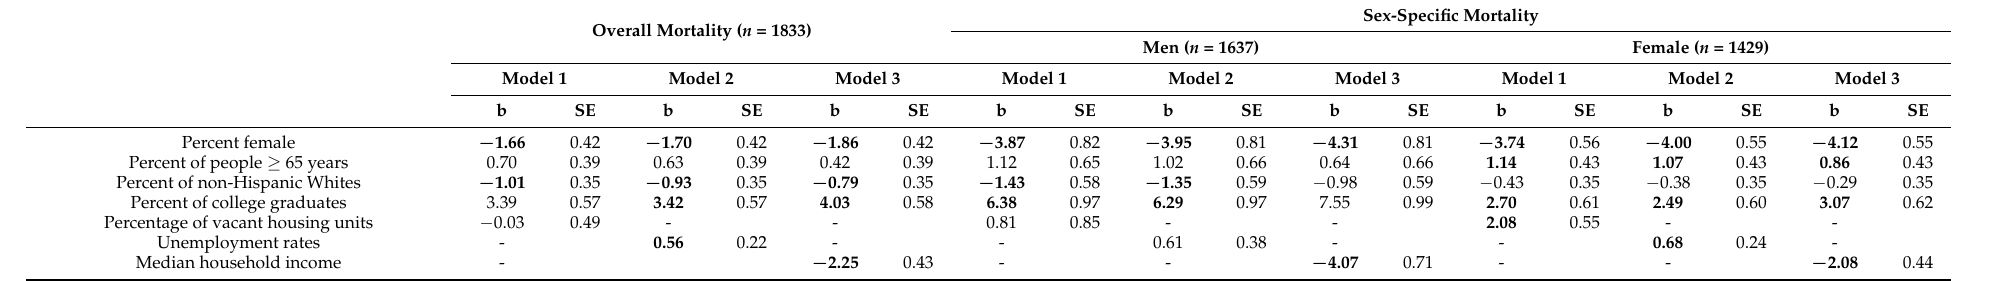
Table 2. Association between county economic changes and changes in county drug mortality rates from 2004–2007 to 2016–2019: Overall and sex-specific mortality rates.